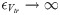
(A) Plot of Hill-type growth rate function as function of the volumetric strain ϵV = ϵV(p), for n = 1, 2 and a large value of n, and for a constant growth scenario (ϵVtr→∞ in Eq (2)). Plot of a linear growth rate function with ϵVtr such that α/α0 = 1/2. Below the pink zone indicated by αqui cells become quiescent and growth stalls. In case of a sharp threshold obtained by the choice of n → ∞, any cell with ϵV<ϵVtr would proliferate with maximal rate α = α0, while any cell with ϵV≥ϵVtr would be quiescent. For finite n, there are also proliferating cells for α < α0. The points on the growth rate curves below which the cells go into quiescence are indicated by an (*). In this work we have found that the parameter set n = 1, ϵVtr=0.35 and αqui = 0.3 results in good fits for all cell lines. (B) simulation snapshots of a CT26 spheroid during the initial free growth, just before confinement (coloring according to cell radius), and at 48h of confinement in capsule (coloring here indicates necrotic cells (dark) and viable cells (white)).